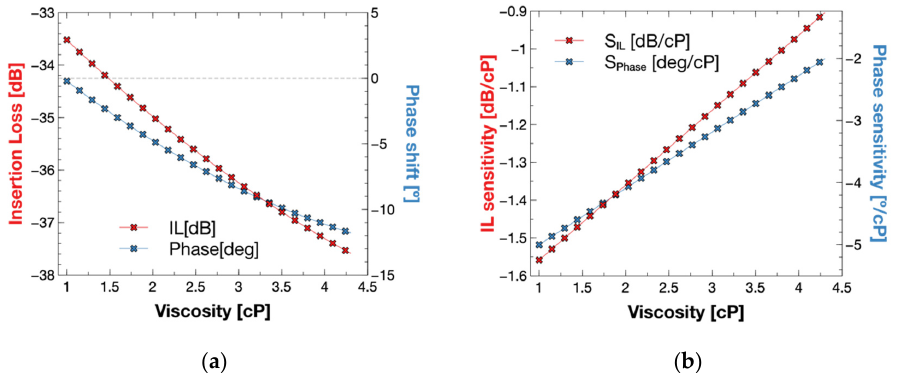
Figure 9. ( a ) TLM Insertion loss and phase model response of the sensor under changes in glycerol- water solutions from 1 cP to 4 cP. The model presents an increment of insertion loss and negative shift of the phase with solutions of higher viscosity. ( b ) Model sensitivity on the sensor for the different viscosities computed as the derivative of the responses.